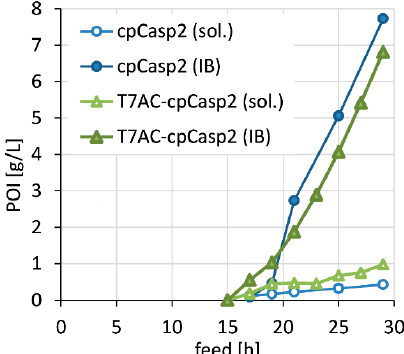
Figure 3. Direct comparison between cpCasp2 production with (T7AC-6H-cpCasp2) and without (6H-cpCasp2) solubility tag T7AC during carbon limited fed-batch cultivation ( µ = 0.1 h − 1 ) with constant 0.5 μ mol IPTG /g CDM: expression of soluble (sol.) and insoluble (IB) POI in the course of time as volumetric titer [g/L].